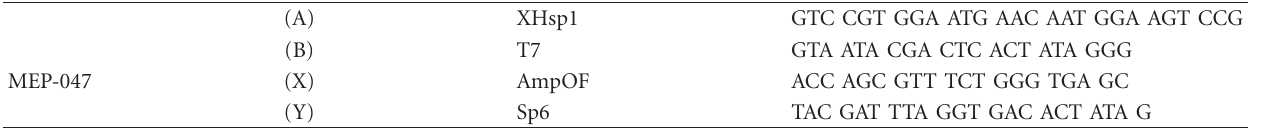
Table 5: LAL reaction screening primers (Section